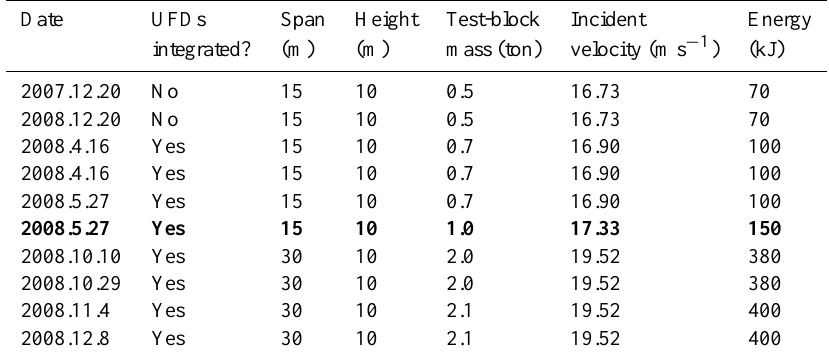
Table 1. The chronological list of the full-scale tests of various LPRs in the past verification and demonstration campaign. The